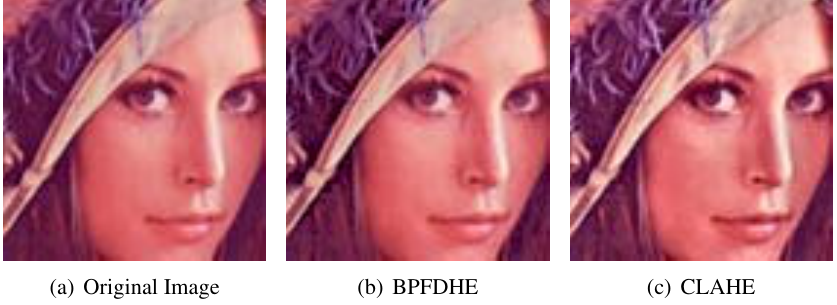
Fig. 6 Original image of Lenna and the output images obtained after applying BPDFHE and CLAHE